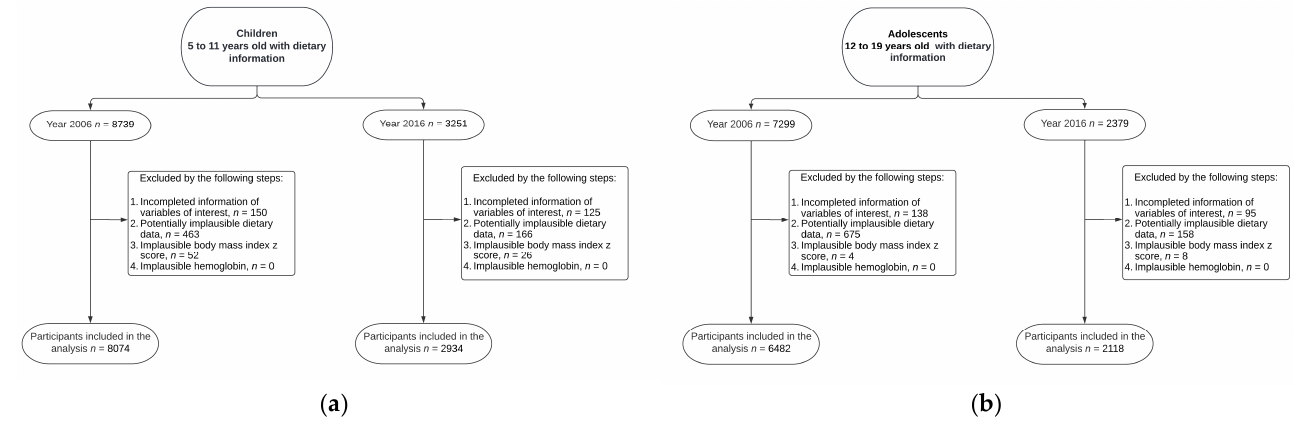
Figure 1. Participant flowchart. ( a ) Children, years 2006 and 2016. ( b ) Adolescents, years 2006 and 2016. Table 1. Characteristics of children and adolescents in 2006 and 2016.